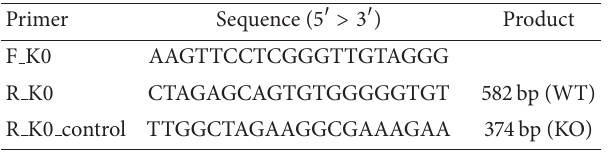
Table 1: Primers pairs used for genotyping. Forward (F) and reverse (R) primers are indicated. WT refers to the RT-PCR product size in wild-type samples and KO refers to the product size in knockout Δ DMR1-U2 transgenic